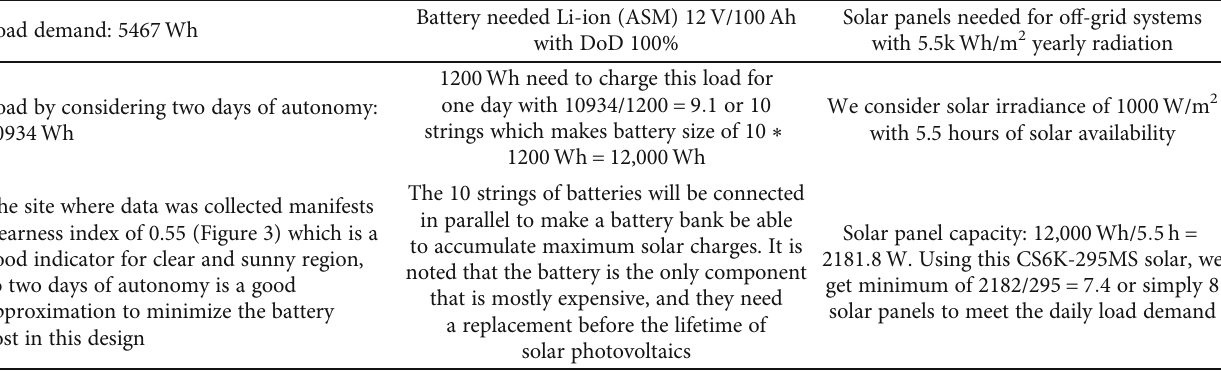
Table 3: The sizing of PV, battery, and converter to supply power to AC load. This case can well fi t in regions far from the national utility. Battery needed Li-ion (ASM) 12 Load demand: 5467Wh